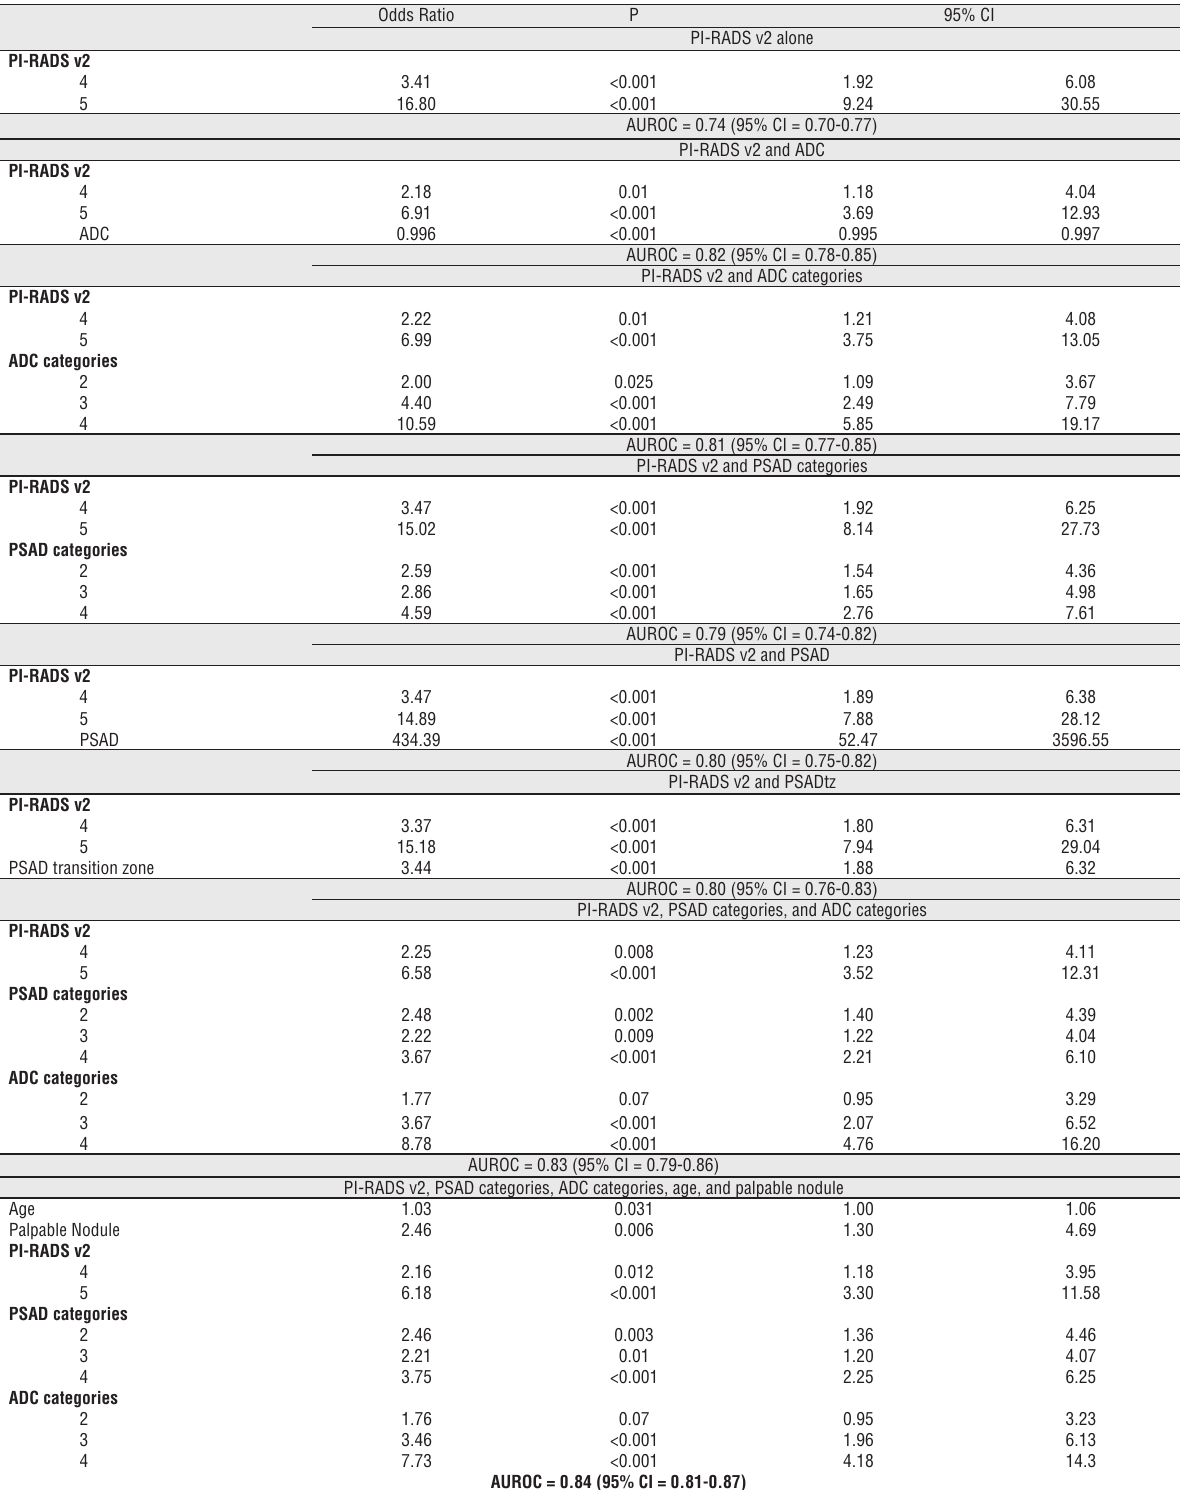
Table 3 - Targeted lesion – logistic regression